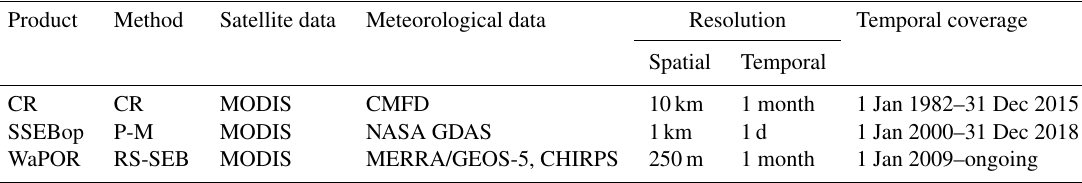
Table 2. Regional ET products.